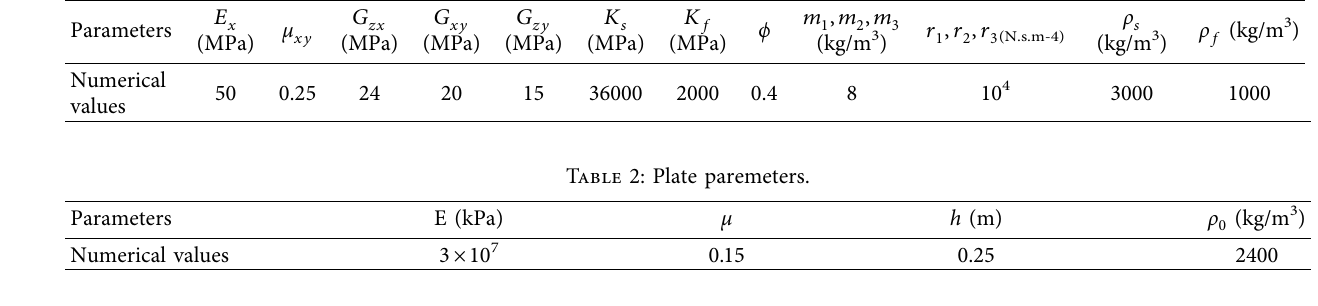
Table 3: Load paremeters.